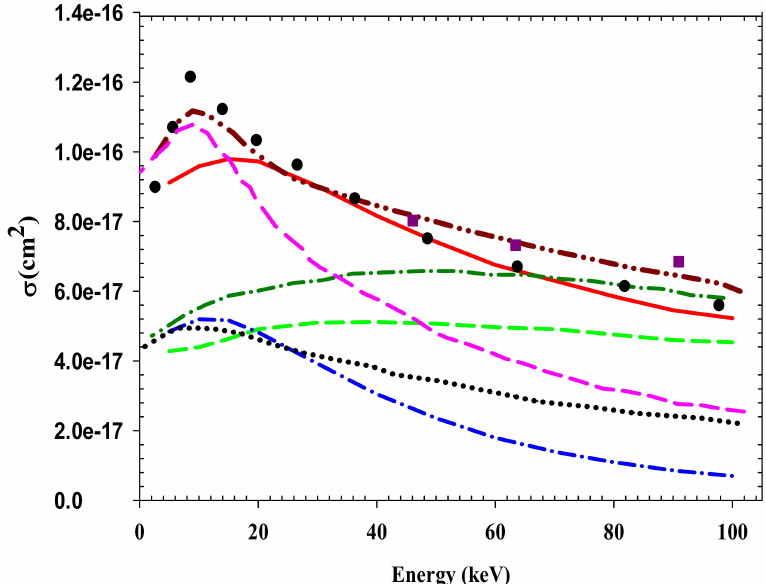
Figure 2. Projectile ionization cross sections in collision between two ground state hydrogen atoms as a function of impact energy. Green dashed line: presents CTMC results for direct ionization (CTMC SI) of the projectile defined by Equation (9). Blue dashed dotted line: presents CTMC results for two-step ionization of projectile defined by Equation (10). Red solid line: projectile ionization cross sections as a result of the sum of the one-step and two-step processes (CTMC EL). Dark brown double-dotted dashed line: the CCC + B2e calculations by Bailey et al. [14]. Dark green dashed dotted line: Born calculations for total electron loss (Born EL). Black dots: Born calculations for single ionization (Born SI). Pink dashed line: CCC calculations for single ionization (CCC SI). Black solid circle: experimental data of McClure [15]. Dark pink square: Experimental data of Wittkower, et al.